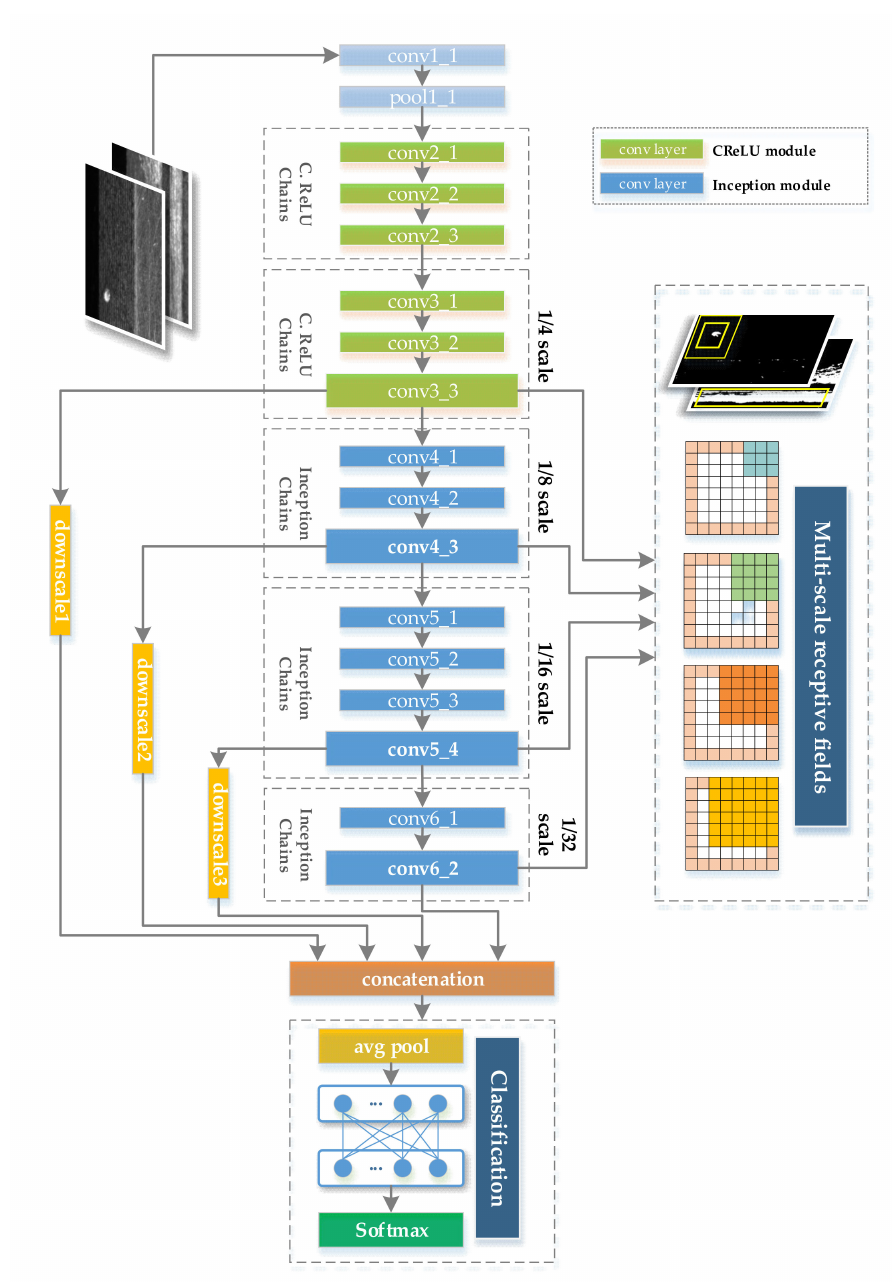
Figure 12. The overall architecture of